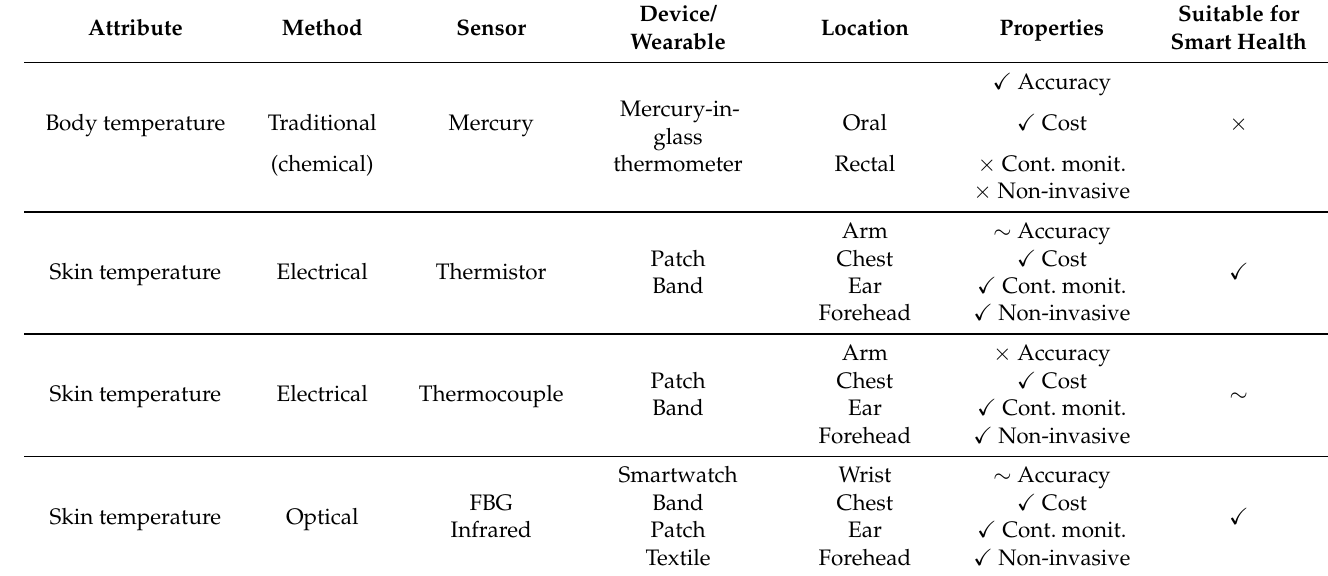
Table 3. Characteristics of the methods for temperature